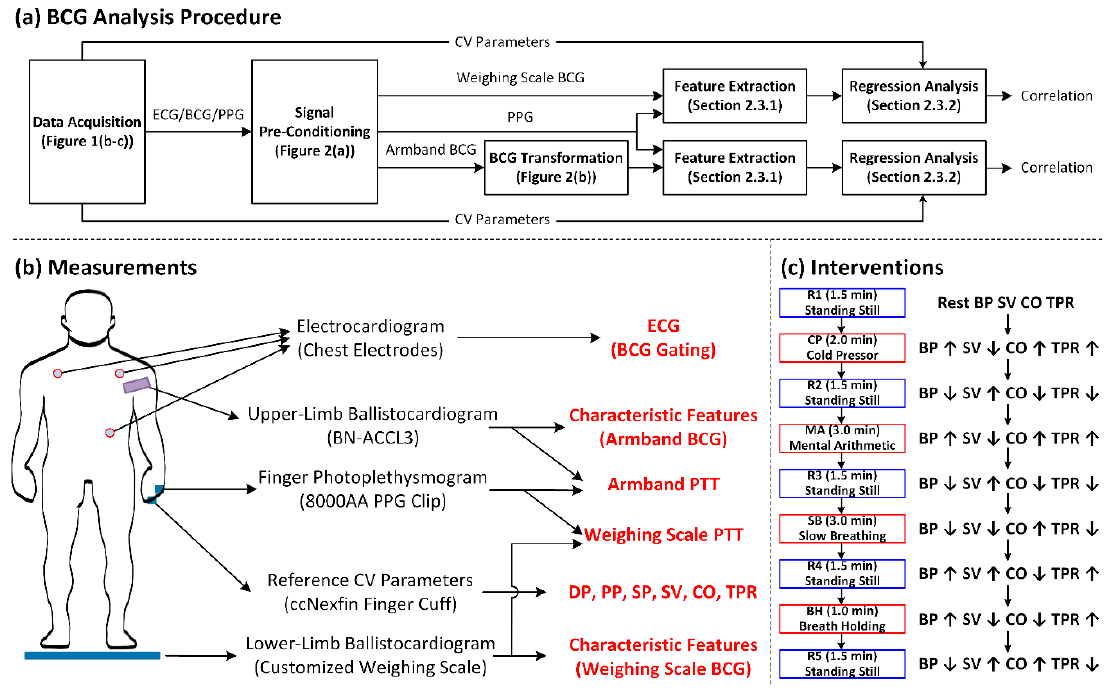
Figure 1. Study design and experimental protocol. ( a ) BCG signal analysis procedure to investigate the potential of limb BCG for cardiovascular (CV) parameter estimation. ( b ) Instrumented physiological signals. ( c ) Hemodynamic interventions. ECG: electrocardiogram. BCG: ballistocardiogram. PTT: pulse transit time. DP: diastolic pressure. PP: pulse pressure. SP: systolic pressure. SV: stroke volume. CO: cardiac output. TPR: total peripheral resistance.